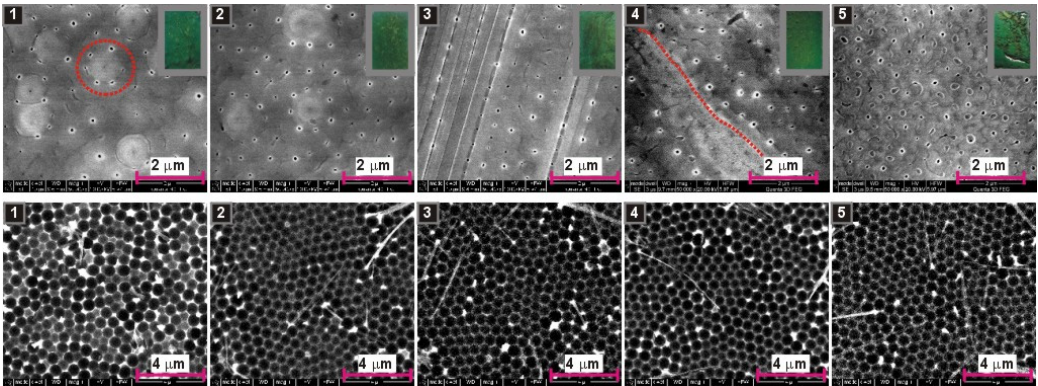
Figure 6. SEM images of AAO—top view (upper row) and nanoconcaves left on aluminum surface after AAO dissolution (lower row) for the samples anodized for 8 h, at 5 °C, 300 V, five times in a row in the same 0.15 M malic acid solution; in the right corners of the SEM images presented in the upper row, photographs of the samples after anodization are shown (in grey frames).